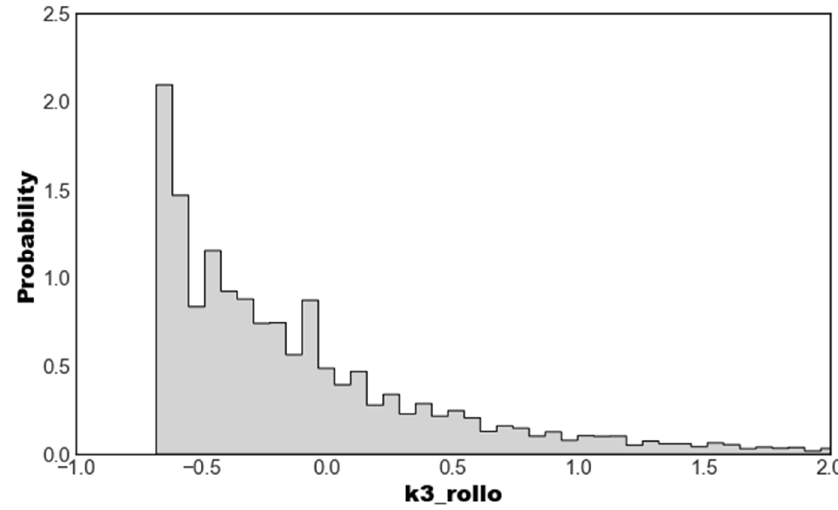
Figure 2. Histogram showing the distribution of the K3 index of the dataset available for the study.